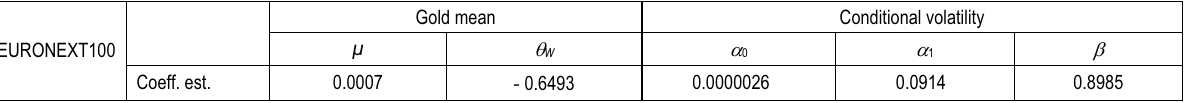
Table 4. Estimation results for stock market indices – reverse causality test 1 Results of GARCH-X (1,1) model with mean equation of gold returns depending on stock markets